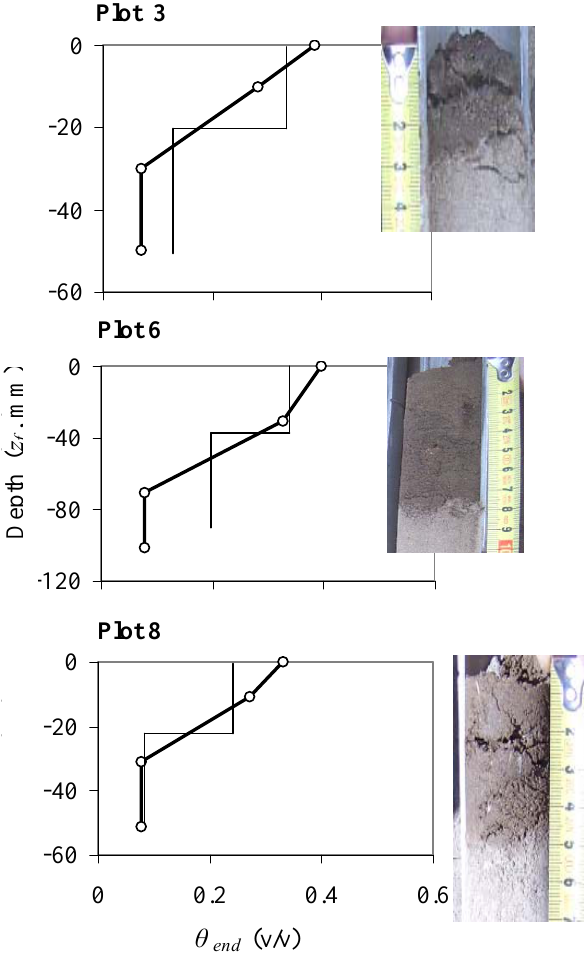
Fig. 4. Comparison of z f (photo insets) and θ end field soil core data (circle-lines) used as an input to the model in this study and esti- mates through CHEMFLO-2000 (lines). Soil core photos obtained immediately after ceasing water inflow are also shown. Fig. 5 . The progression of overland flow A(t) and DS areas during the water inflow periods in three field plots as estimated from rectified video imagery and the model used in this study.